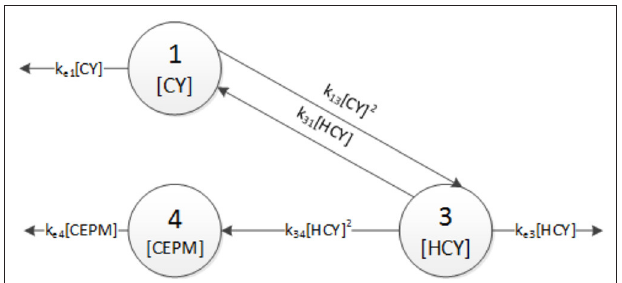
FIGURE 4 | Compartmental model with six unknown parameters.